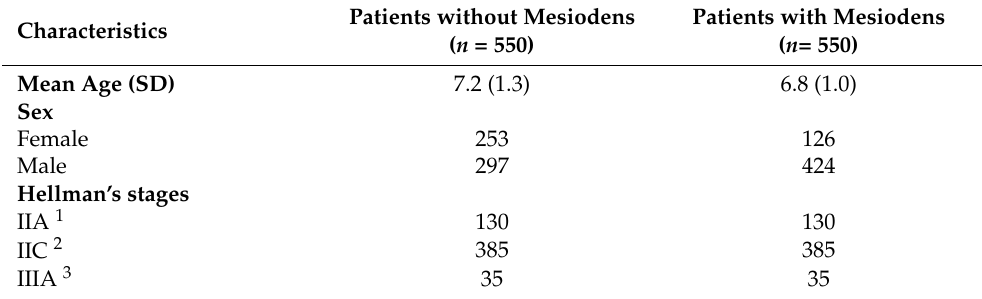
Table 1. Demographic data of subjects in this study.